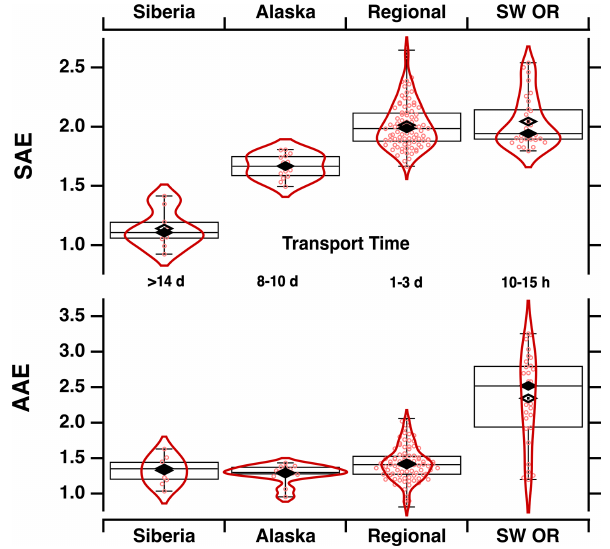
Figure 2. Combined violin and box plots of 1h average SAE and AAE values for July–September 2019 BB events observed at MBO grouped by source (Siberia, Alaska, regional, SW OR). SAE de- scribes particle sizes, with small values indicating large sizes, and AAE describes particle composition with larger values, indicating greater BrC content. Violin plots in red show the rotated Gaussian kernel probability density, with the mean shown as an open dia- mond, the median shown as a solid diamond, and 1h average val- ues shown as open circles. Boxes in black represent upper and lower quartiles, with whiskers representing the minimum and